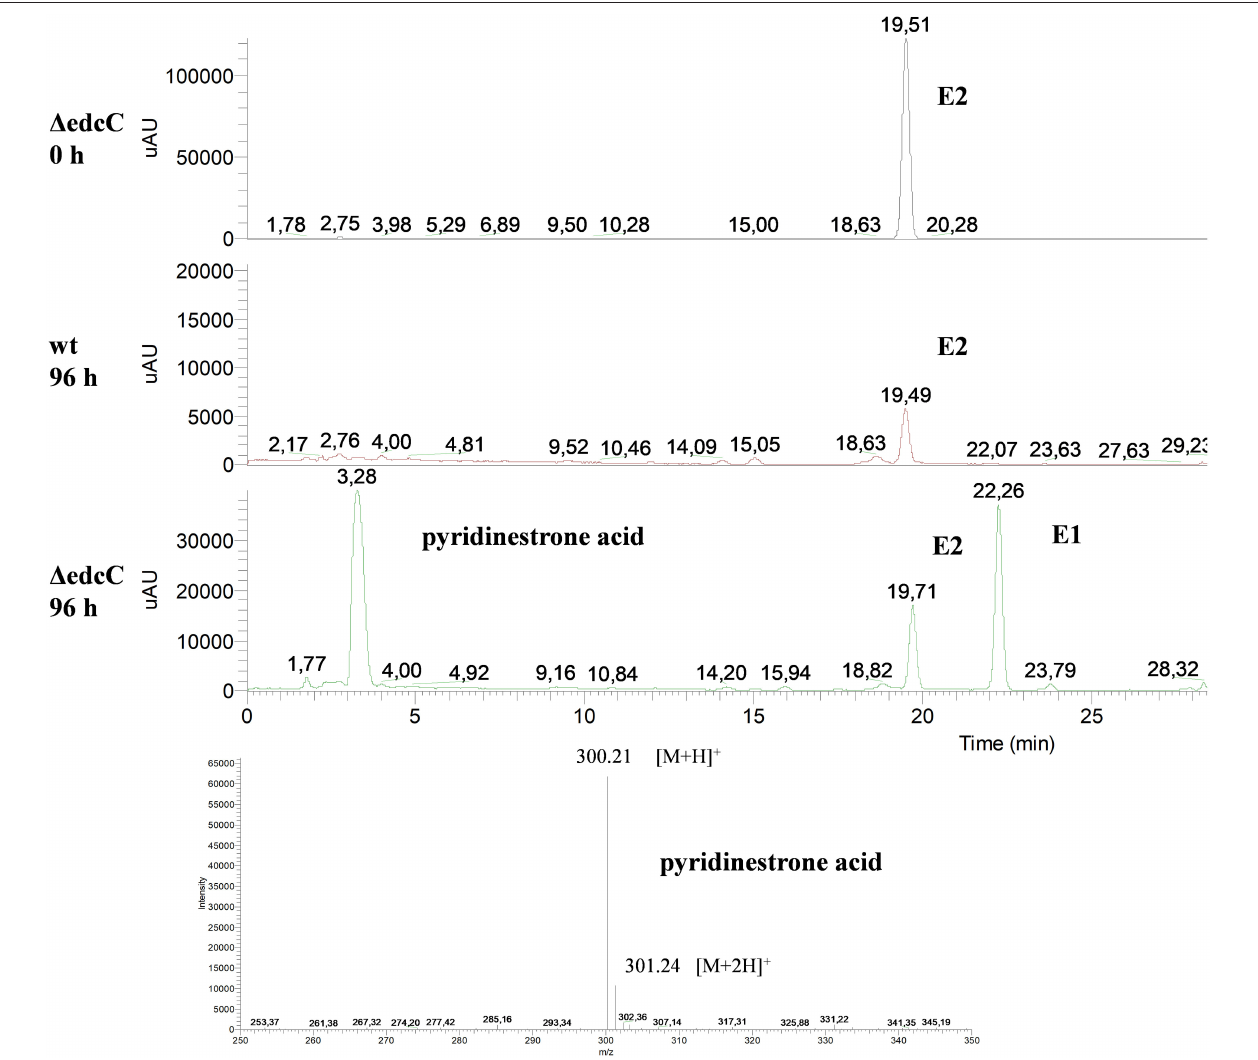
FIGURE 9 | HPLC-MS analysis of the organic phase extracted from cultures of N. tardaugens 1 edcC in NB rich medium supplemented with 2mM E2. UV chromatograms at 282nm of the samples at 0 and 96h for 1 edcC strain and 96h for wt strain and mass spectrum of the peak detected at 3.28min (pyridinestrone